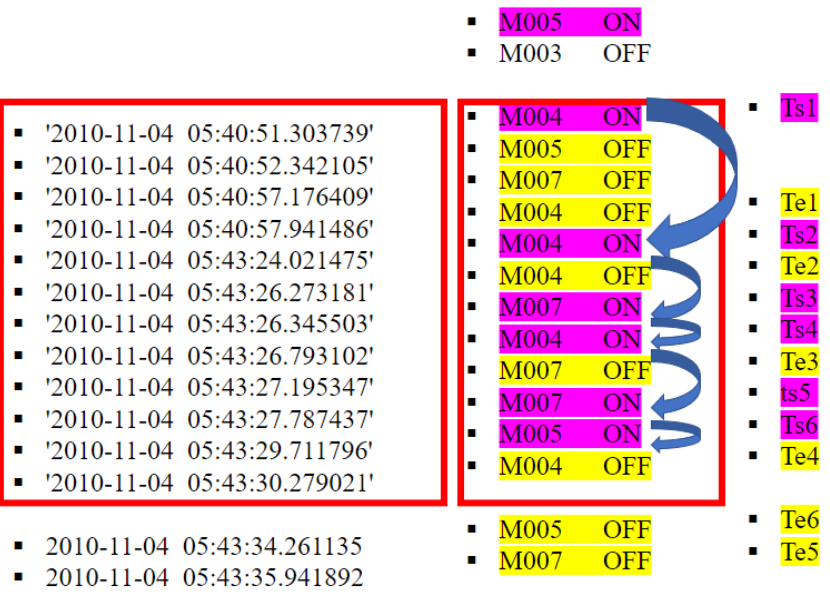
Figure 4. Segment of activity.